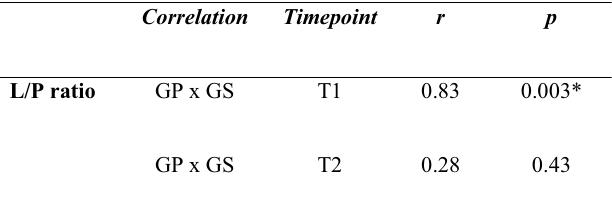
TABLE 3 - Pearson correlation between groups GP and GS for lactate/pyruvate ratio